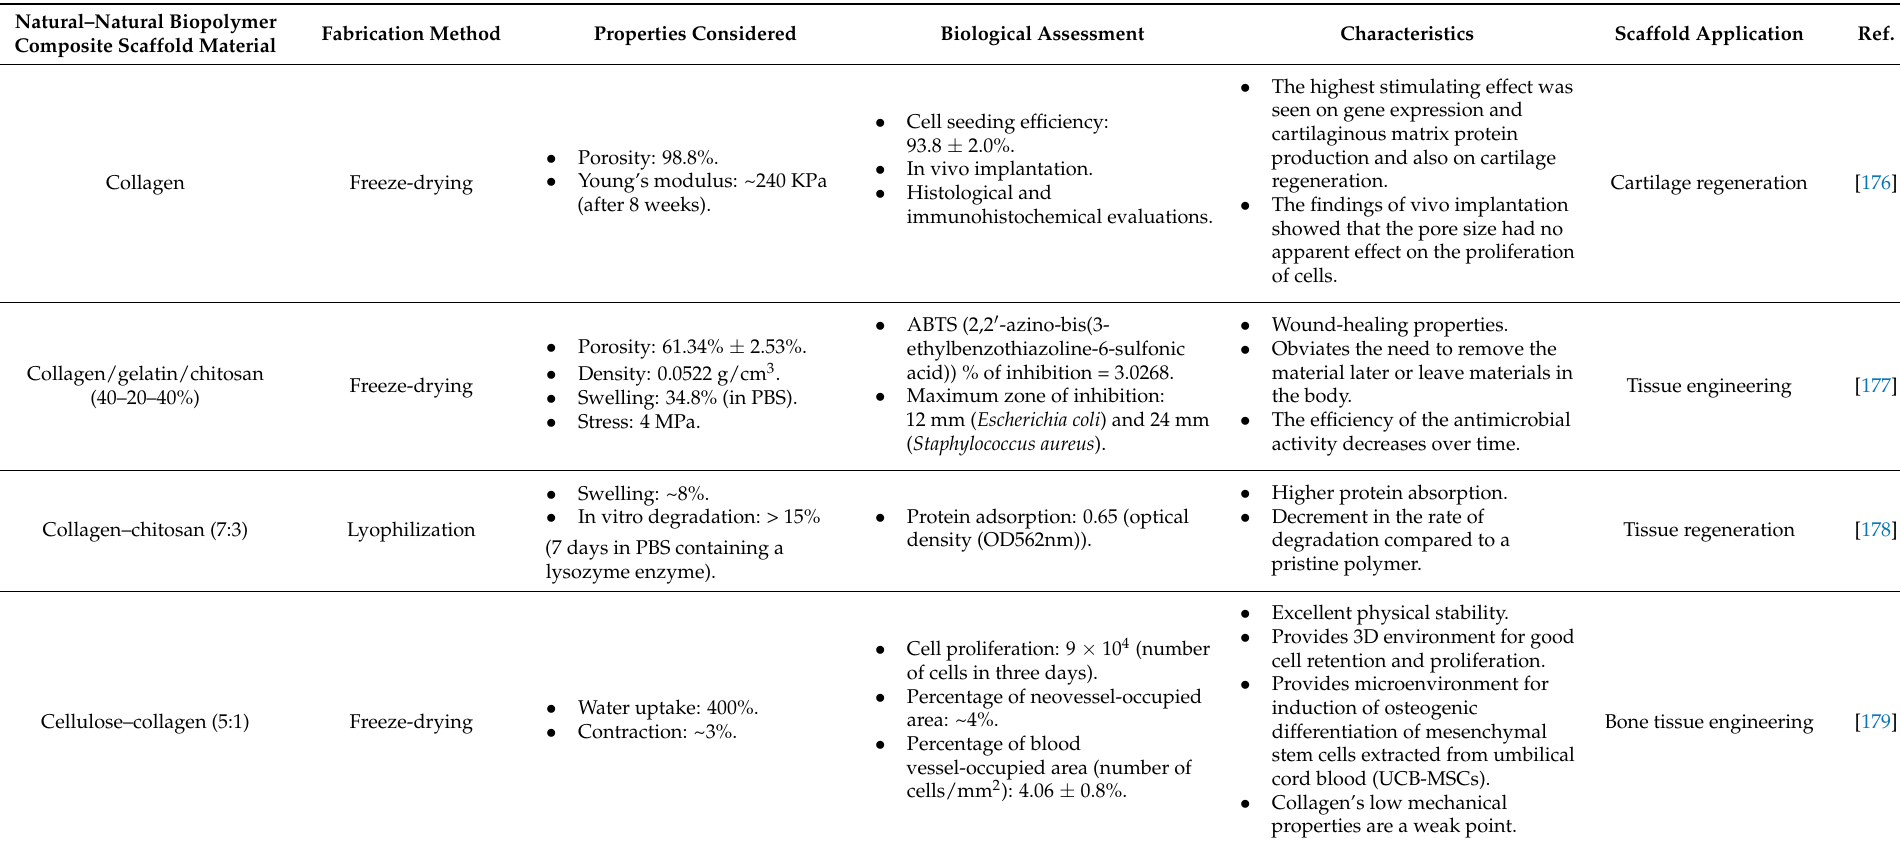
Table 2. Comprehensive analysis of natural biopolymer blends (composites) along with their fabrication route, properties, biological assessment, and characteristics. Natural–Natural Biopolymer Composite Scaffold